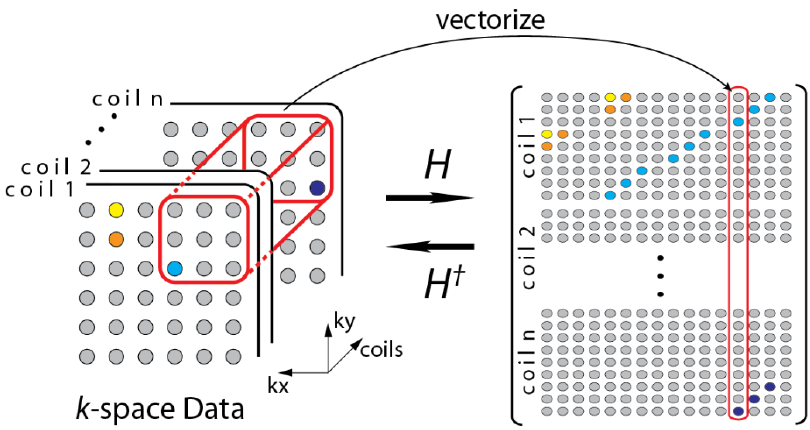
Figure 3. Formation of low-rank hankel